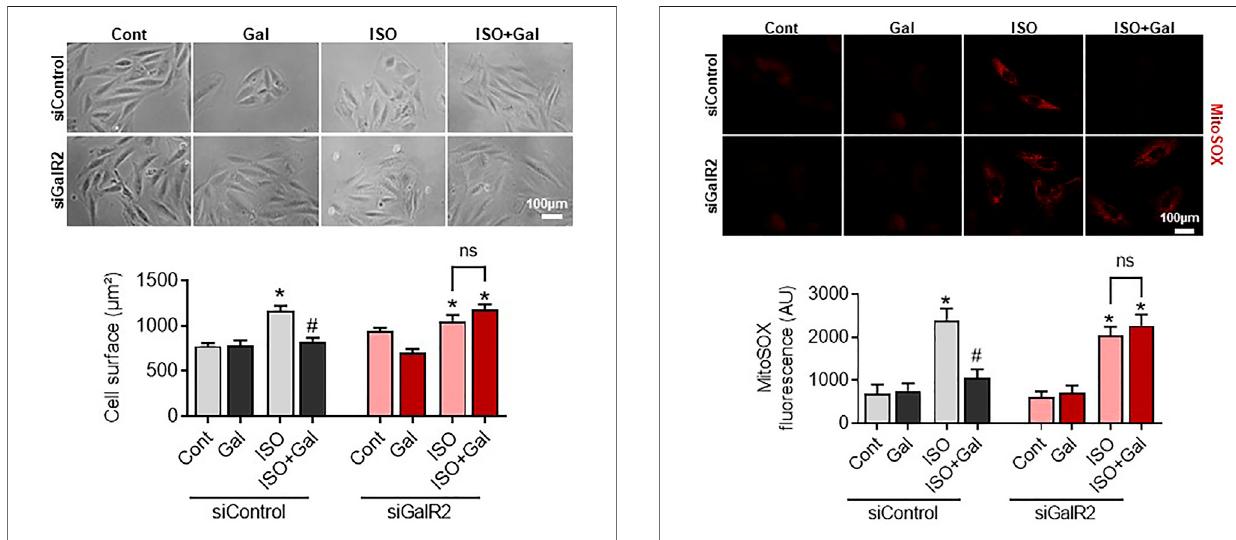
FIGURE 6 | Galanin decreases mitochondrial ROS production via GalR2. Representative images and quanti fi cation of MitoSox Red staining in H9C2 cells transfected with control siRNA (siControl) or GalR2 siRNA (siGalR2) under isoproterenol-induced stress (ISO). Data represents the mean ± SEM from three independent experiments. * p < 0.05 vs. control; # p < 0.05 vs.